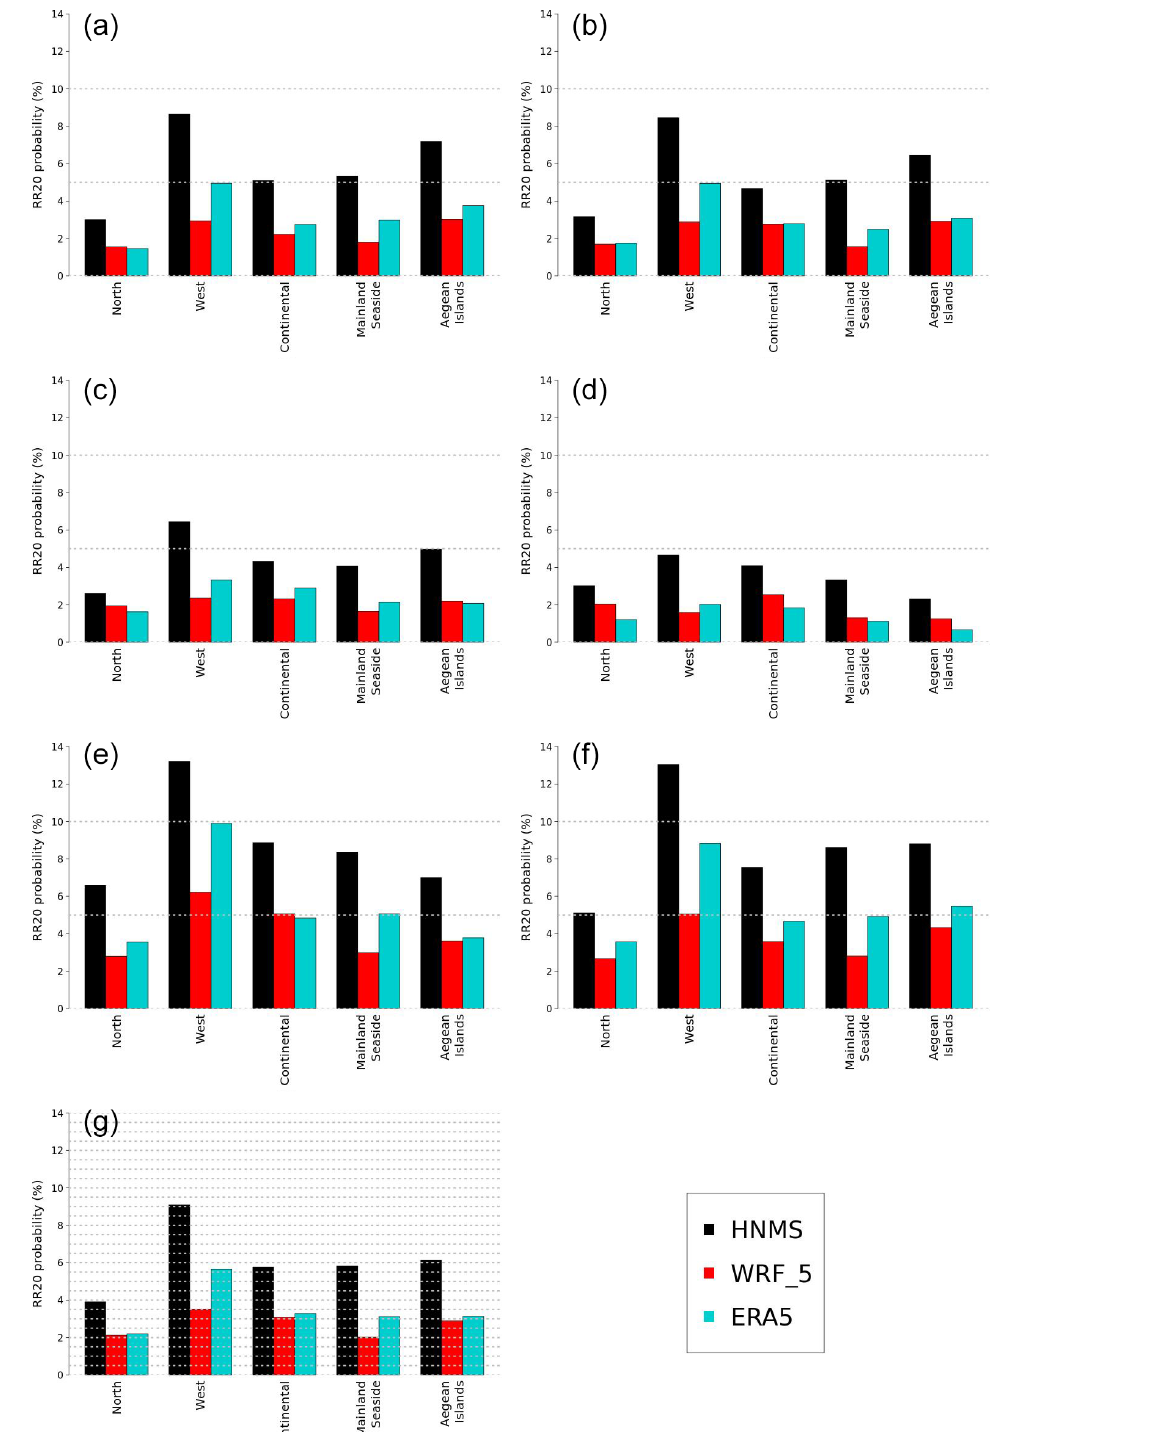
Figure B1. RR20 aggregated probabilities for HNMS, WRF_5 and ERA5 five station categories for the months (a) January, (b) February, (c) March, (d) April, (e) November, (f) December and (g) for the entire season November–April.